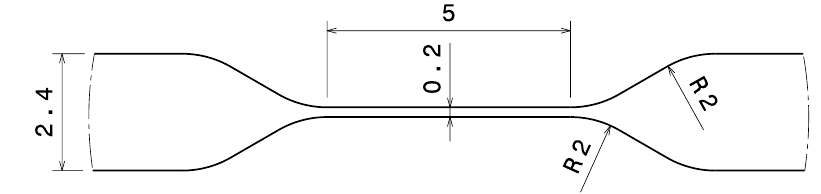
Figure 9. Flexure hinge design